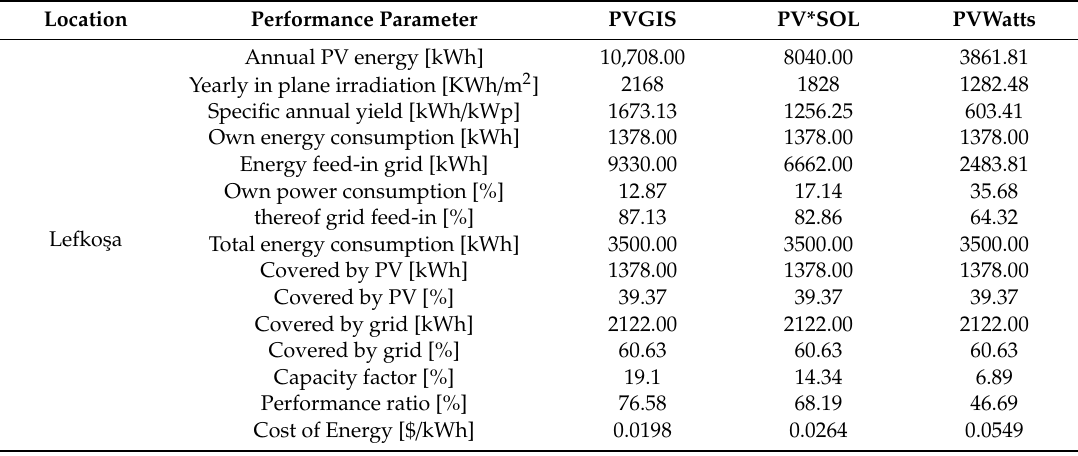
Table 9. Capacity factor and Generated electricity of wind turbine